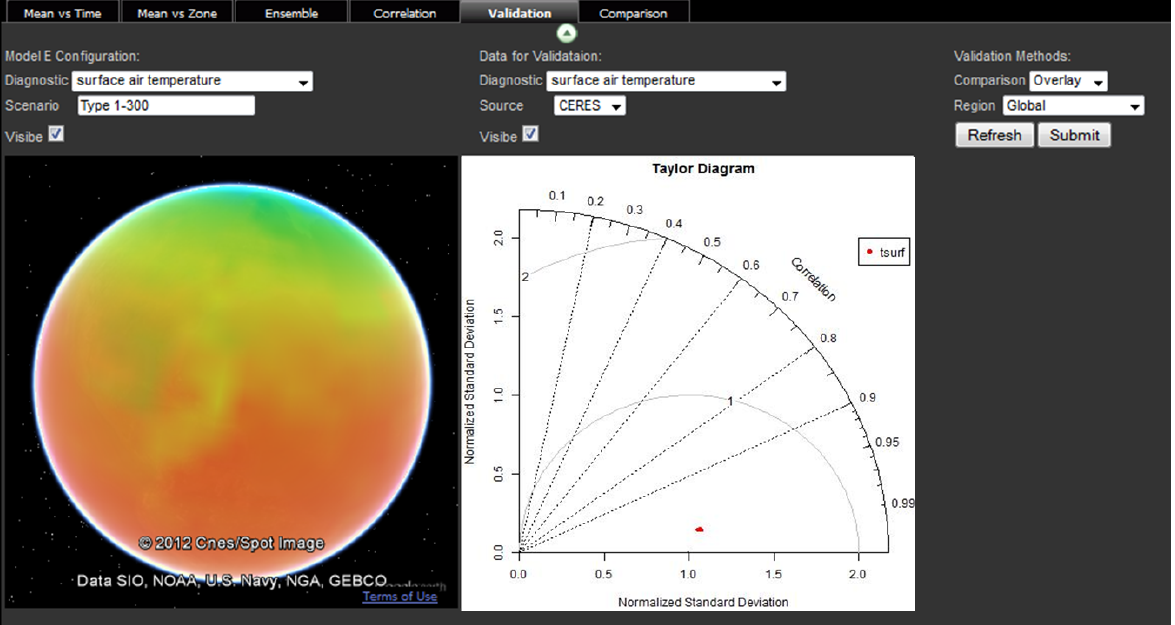
Figure 9. Client interface for evaluating the quality of simulation and the result of evaluation.